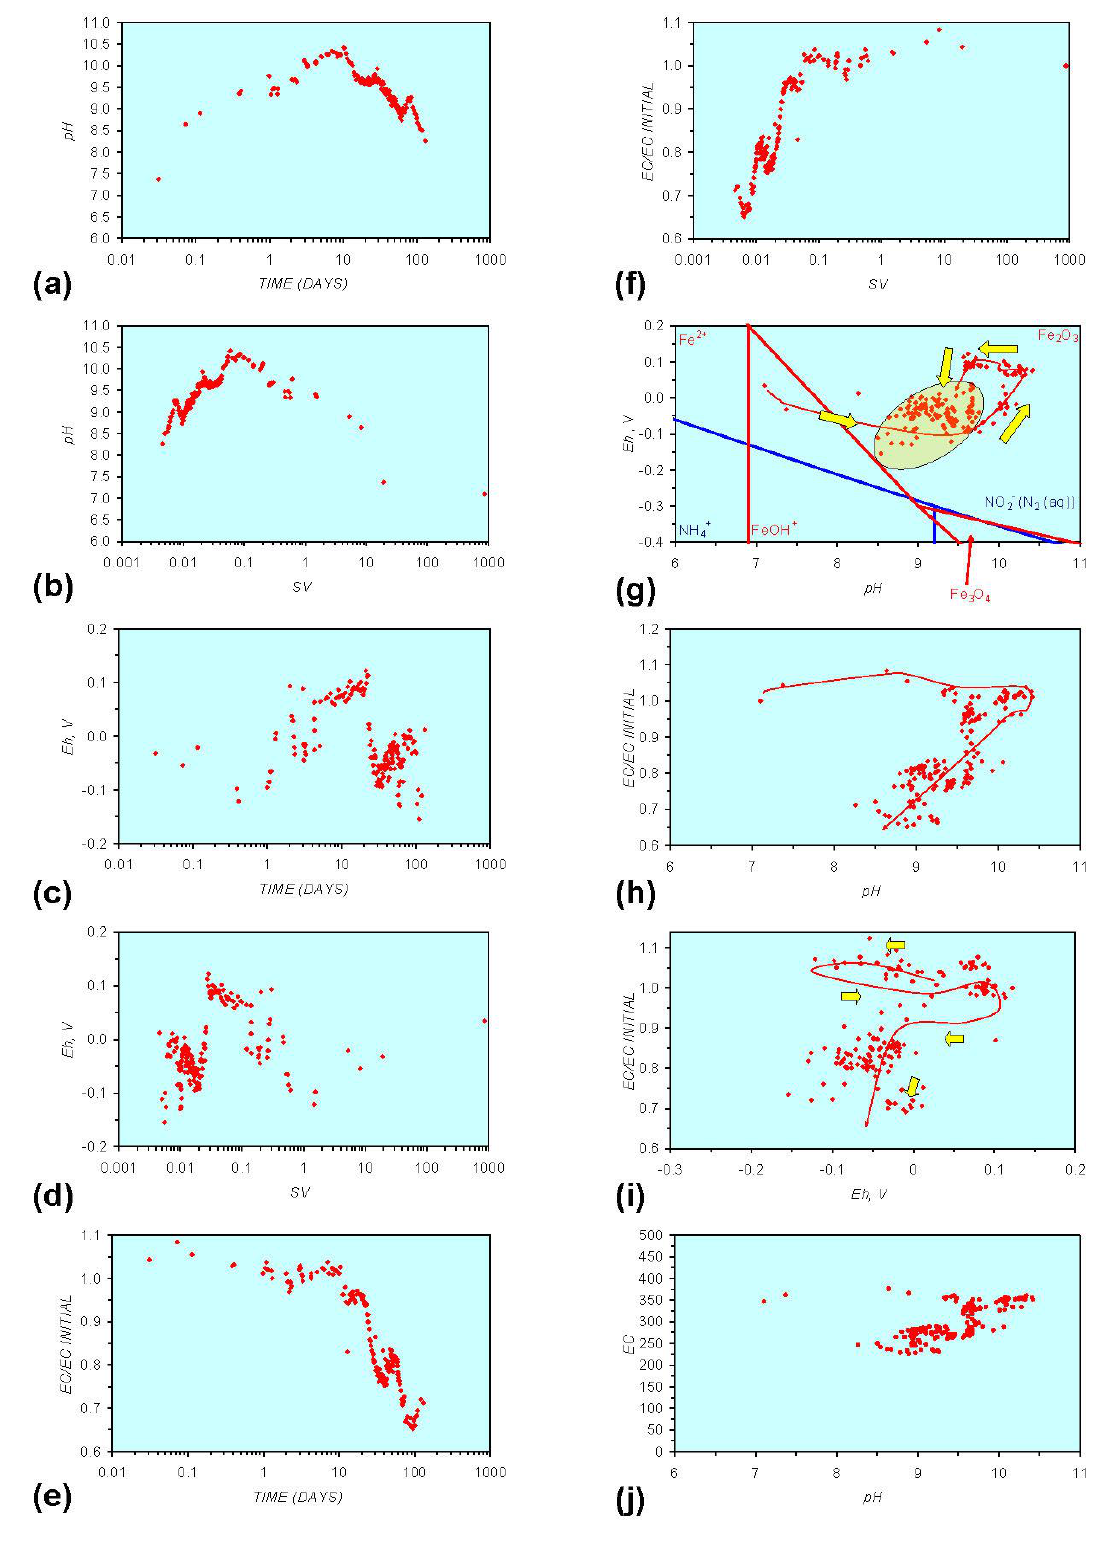
Figure A3. MR3: n-Fe 0 + n-Cu 0 , fresh water. (a) pH vs. Time; (b) pH vs. SV; (c) Eh vs. time; (d) Eh vs. SV; (e) EC/EC Initial vs. time; (f) EC/EC Initial vs. SV; (g) Eh vs. pH (SRE ringed); (h) pH vs. EC/EC Initial; (i) Eh vs. EC/EC Initial; (j) pH vs. E(C) Arrows indicate decreasing SV and increasing